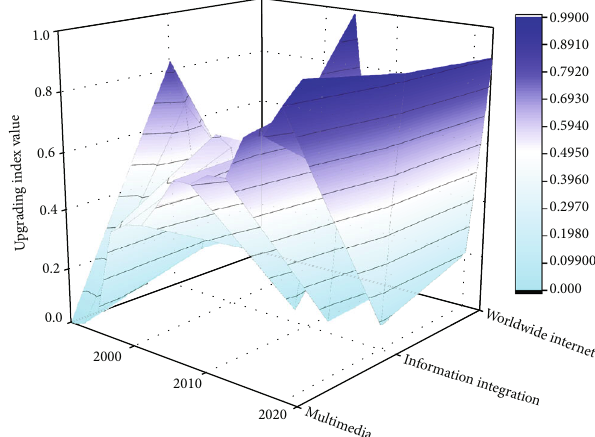
Figure 5: Changes in multimedia usage information from 1992 to